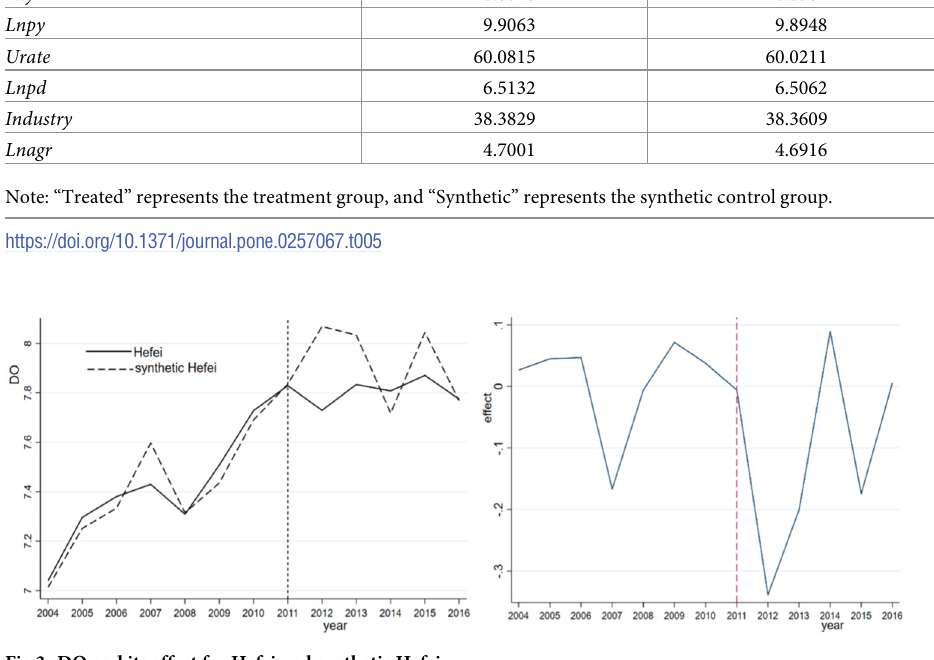
Table 5. Treatment and synthetic control groups of the predictive variables for NH 3 N. Predict Variables